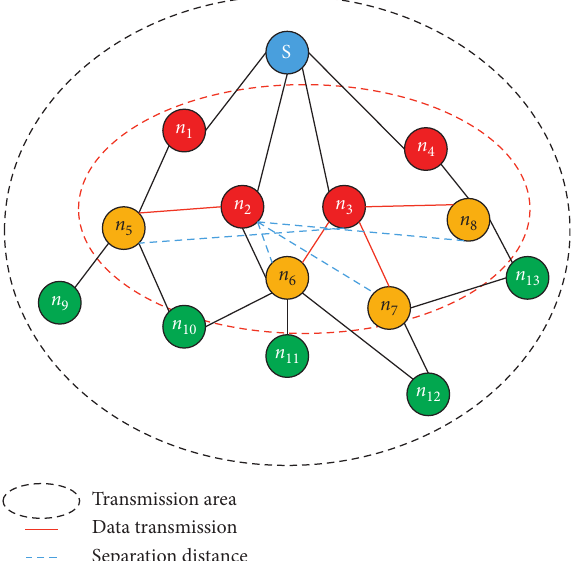
Figure 8: Broadcast link scheduling in community